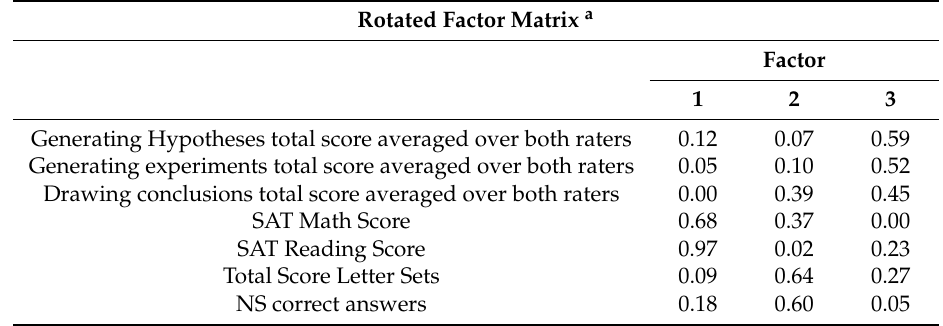
Table 16. Rotated maximum likelihood common factor analysis with sat and analytical ability